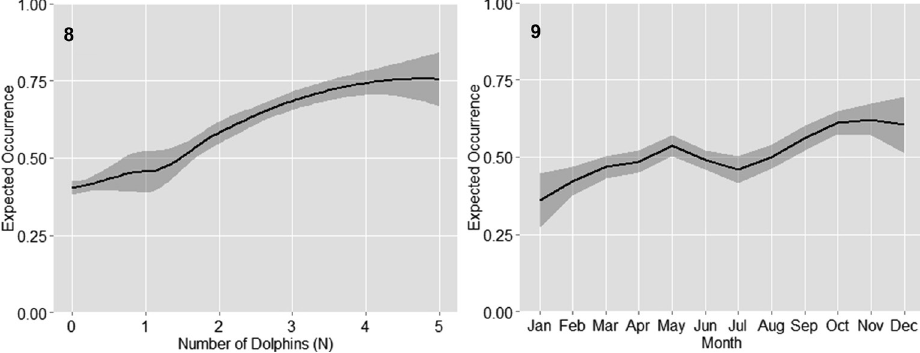
Figures 8–9. Expected occurrence of Mugil liza for predictors of the binomial model. Number of dolphins (8) and month (9); the black lines indicate the moving averages; dark gray areas represent the 95% confidence intervals of the predictions.